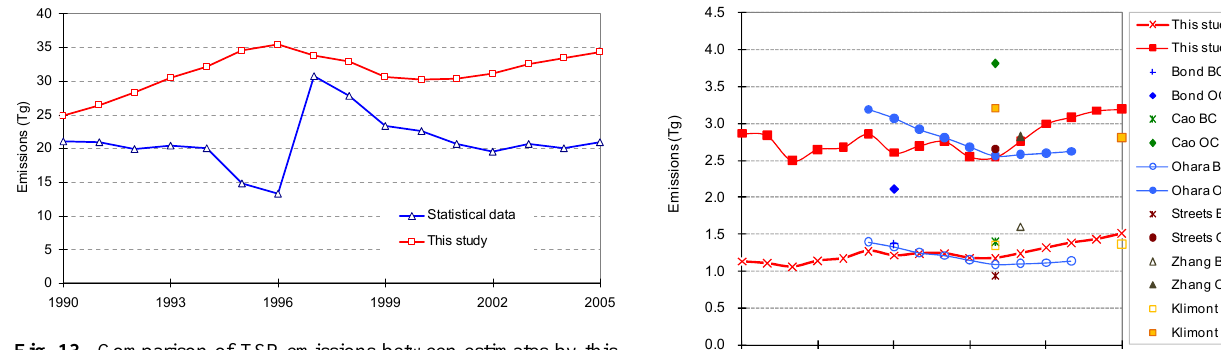
Fig. 13. Comparison of TSP emissions between estimates by this study and China’s government statistical data.